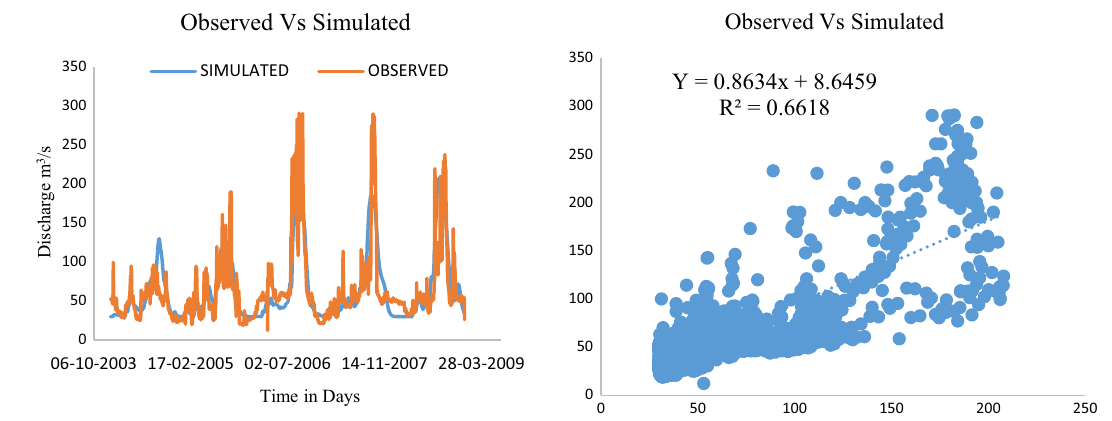
Fig. 6 Simulated versus observed flow data for green and Ampt after calibration Fig. 7 Model validation result